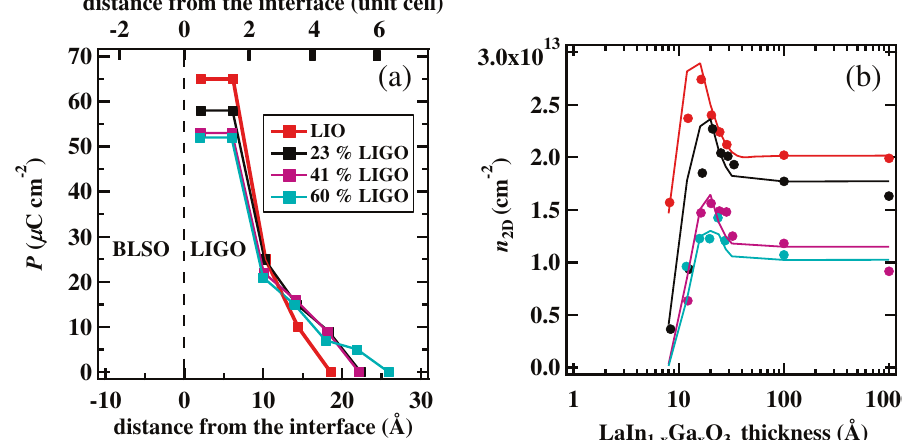
Fig. 6 Self-consistent Poisson – Schrödinger simulation for 0.3% BLSO/LIGO interface. N DD = 2 × 10 20 cm − 3 was used in all LIGO layers within 5 nm near the interface. a Interface polarization values used for simulation. b Comparison of n 2D by experiments (dots) with those by simulation (lines).